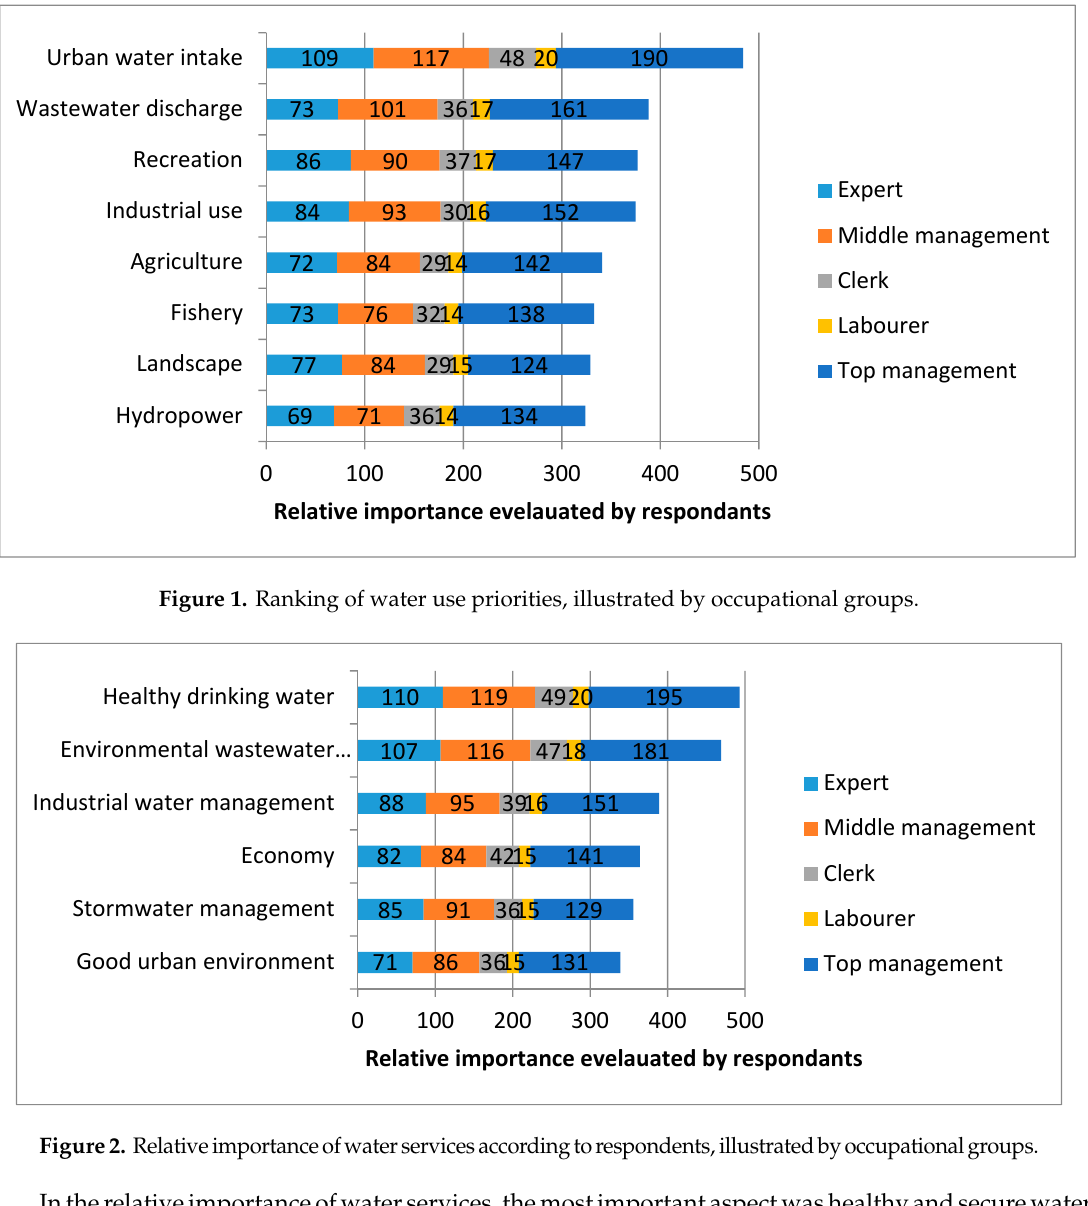
Figure 2. Relative importance of water services according to respondents, illustrated by occupational groups.